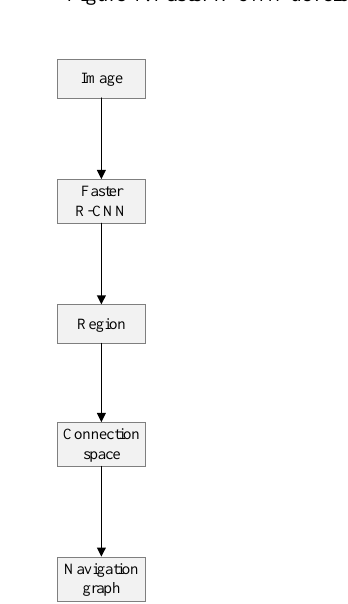
Figure 1. Faster R-CNN developing history and core mechanism explanation